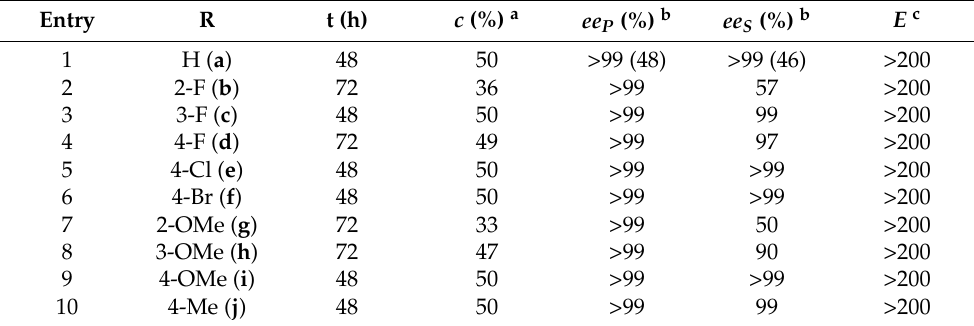
Table 5. Lipase-catalyzed kinetic resolution of trans - 2a-j (100 mM) by acetylation using AK lipase (1:1 w/w substrate:enzyme) and vinyl acetate (VinOAc) as both acyl donor and solvent at 30 ◦ C and 250